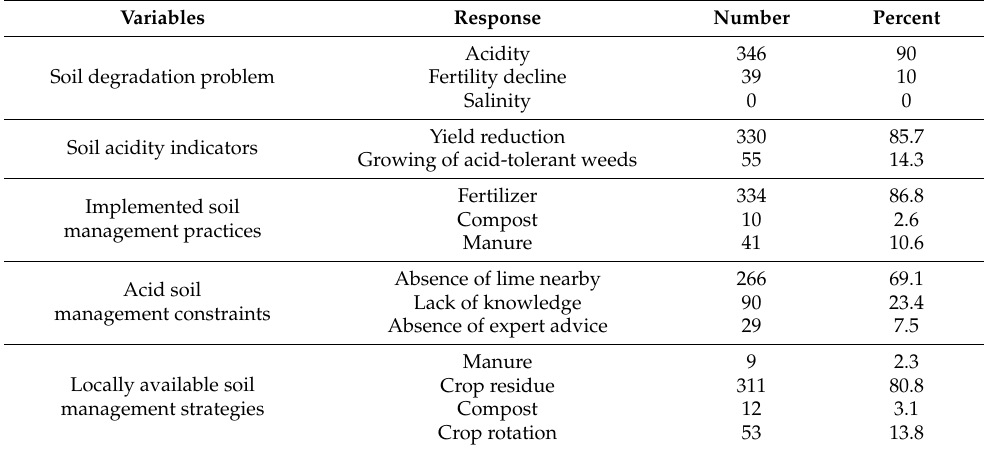
Table 8. Perceived soil management problems and farmers’ management practices.